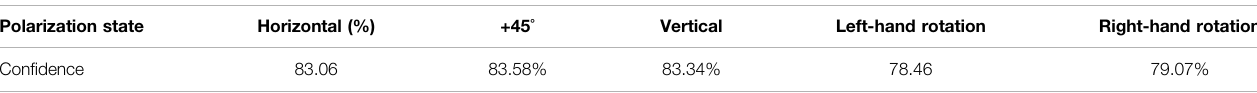
TABLE 2 | Calculation results of con fi dence of 450 nm polarized light simulation and test veri fi cation. Polarization state